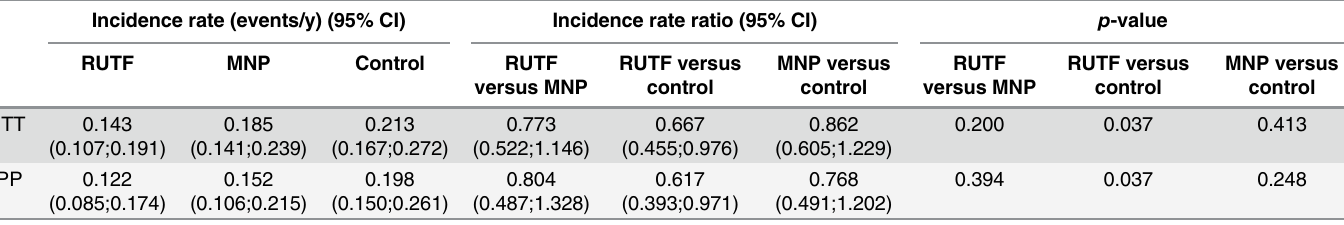
The incidence of first NNO event was 0.143, 0.185, and 0.213 events per year for the RUTF, MNP, and control groups, respectively, during the 6 mo of follow-up (Table 3). The RUTF group showed a significant reduction in the incidence of NNO of 0.070 events/year or a reduc- tion of 33.3% ( p = 0.037) compared with the control group. The RUTF group showed a nonsig- nificant reduction of 0.042 events/y (22.7%) in incidence compared with the MNP group ( p = 0.200), and the reduction in incidence in the MNP group compared with the control group was 0.028 events/y (13.8%) ( p = 0.413). Analysis of the per protocol dataset ( n = 1,558) did not show a major difference from the intention to treat dataset. The incidence of NNO was 0.122 events/y for the RUTF group, 0.152 events/y for the MNP group, and 0.198 events/y for the control group during the 6 mo of fol- low-up. The incidence in the RUTF group was 39.3% lower compared with the control group ( p = 0.037) and 19.6% lower compared with the MNP group ( p = 0.394), and the incidence in the MNP group was 23.8% lower than the control group ( p = 0.248) (Table 3). A total of 166 participants developed moderate malnutrition (weight-for-height z-score between − 2 and − 3): 44 (6.09%) in the RUTF group, 56 (7.70%) in the MNP group, and 66 (9.14%) in the control group. Sixteen participants developed severe malnutrition (weight-for- height z-score < − 3, MUAC < 115 mm, or oedema): 4 (0.55%) in the RUTF group, 9 (1.24%) in the MNP group, and 3 (0.42%) in the control group. None of the participants developed oedema. Subgroup analyses suggested that the effect of supplementation on the incidence of NNO was not modified by socioeconomic characteristics, season of enrollment, age of the partici- pant, breastfeeding status, or study disease at enrollment (Table 4). Table 3. Incidence of first NNO per y. Incidence rate (events/y) (95%